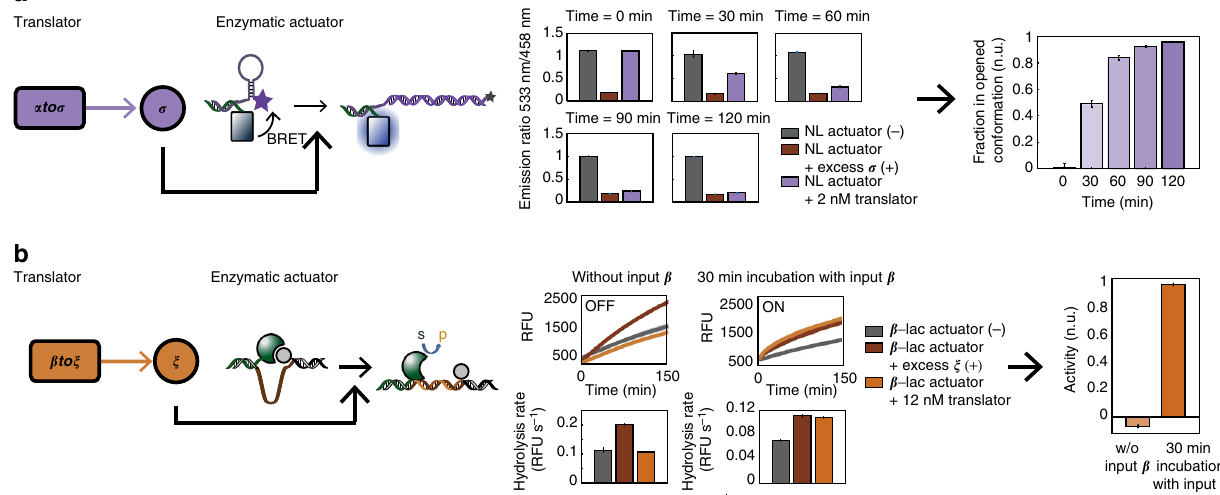
Fig. 5 The control of enzymatic actuators by the translator module. a Schematic illustration (left) and experimental results (right) of controlling a NanoLuc (NL)-based actuator by the translator module. Experiments were performed using 2 nM of α to σ , 5 nM of the NanoLuc-based actuator, 15 U mL − 1 Bst 2.0 WarmStart DNA polymerase, 10 U mL − 1 Nt. bstNBI, and initiated with 30 nM α . The opening of the stem-loop structure of the NanoLuc-based actuator was quanti fi ed at intervals of 30 min by measuring the BRET ratio between the NanoLuc donor (em. = 458nm) and FAM acceptor dye (em. = 533 nm). The translator module was omitted for negative ( − ) and positive (+) controls and excess of DNA strand σ was added for the positive controls. Experiments were performed in triplicate and the fraction in opened conformation in normalized units (n.u.) was calculated by subtracting the mean BRET ratio of the positive controls and normalizing to the mean BRET ratio of the negative controls. Error bars and shaded areas represent the standard error of the mean of the experiments. b Schematic illustration (left) and experimental results (right) of the activation of the self-inhibitory TEM1 β -lactamase ( β -lac) actuator by the translator module. Experiments were performed using 12 nM β to ξ , 2.5 nM TEM1 β -lactamase/BLIP actuator, 15 U mL − 1 Bst 2.0 WarmStart DNA polymerase, 10 U mL − 1 Nt. bstNBI, and initiated with 30 nM β . The activity of TEM1 β -lactamase was measured at time = 0 min prior to initiation with β and 30 min after activation of the translator module and was quanti fi ed by measuring the hydrolysis rate of fl uorogenic substrate CCF2-FA obtained from the linear regime of the fl uorescent time traces. The translator module was omitted for negative ( − ) and positive (+) controls and excess of DNA strand ξ was added for the positive controls. Experiments were performed in triplicate and the activity in normalized units (n.u.) was calculated by subtracting the mean hydrolysis rate of the negative controls and normalizing to the mean hydrolysis rate of the positive controls. Error bars and shaded area ’ s represent the standard error of the mean of the